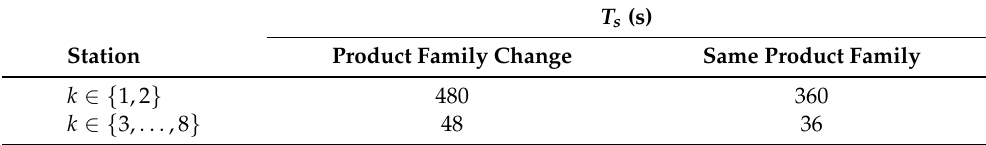
Table 5. Setup time input